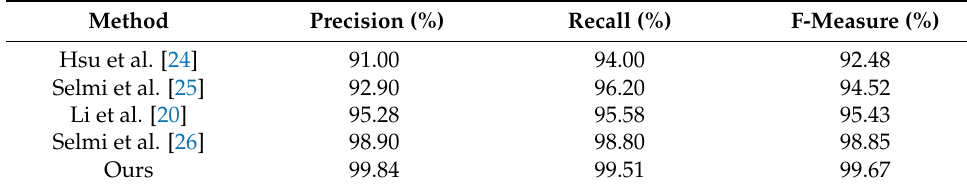
Table 5. Detection results on AOLP-RP.